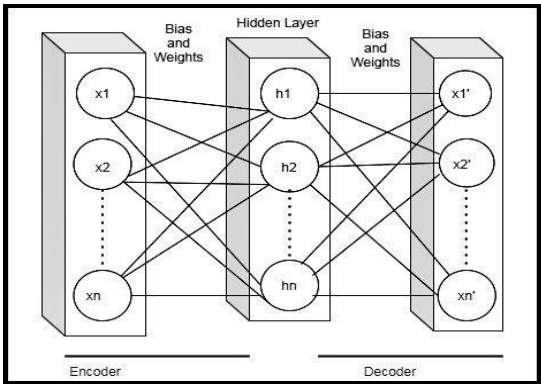
Figure 6. The autoencoder architecture.